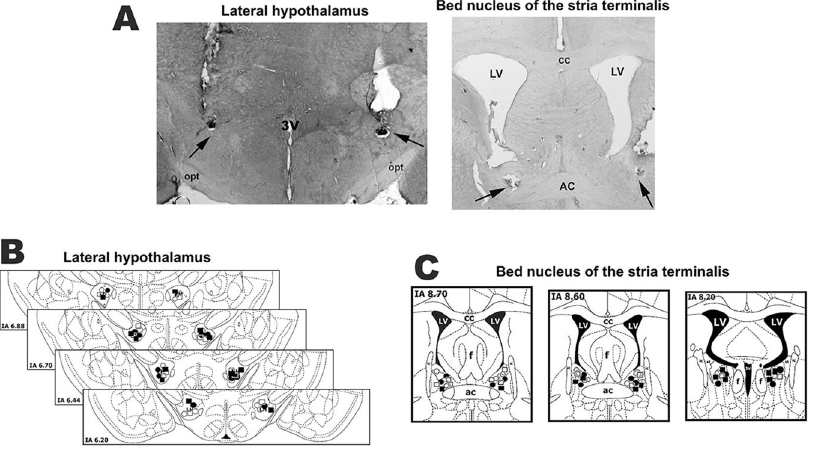
Figure 5. ( A ) Photomicrographs of coronal brain sections from representative rats showing bilateral sites of microinjection into the lateral hypothalamus (LH) (left) and bed nucleus of the stria terminalis (BNST) (right). ( B , C ) Diagrammatic representations based on the rat brain atlas of Paxinos and Watson 58 indicating the microinjection sites into the lateral hypothalamus ( B ) and BNST ( C ) of all animals used for evaluation of the involvement of GABA A receptor within the LH in cardiovascular changes evoked by microinjection of the selective CB 1 receptor antagonist AM251 into the BNST. White circles: saline LH + DMSO BNST group; black circles: saline LH + AM251 BNST group; white squares: SR95531 LH + DMSO BNST group; black squares: SR95531 LH + AM251 BNST group. 3V third ventricle, ac anterior commissure, cc corpus callosum, f fornix, IA interaural coordinate, ic internal capsule, LV lateral ventricle, opt optic chiasm, st stria